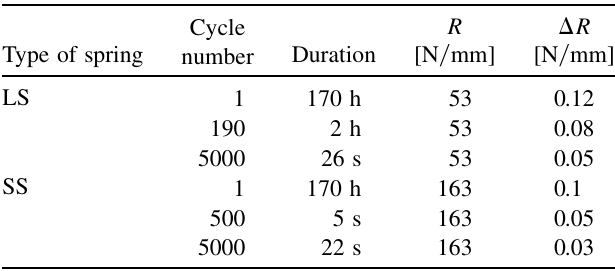
corners ( (cid:5) 25 mm ), h I z i is large ( (cid:1) 40 (cid:4) 10 (cid:1) 6 and 75 (cid:4) 10 (cid:1) 6 Tm , respectively). The peaks of h I